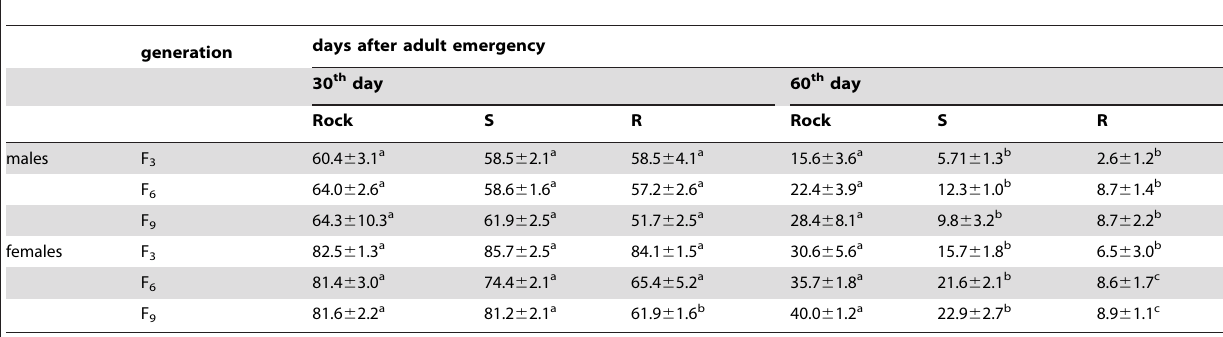
Table 1. Adult longevity of an Aedes aegypti field population submitted to controlled pyrethroid selection in the laboratory.